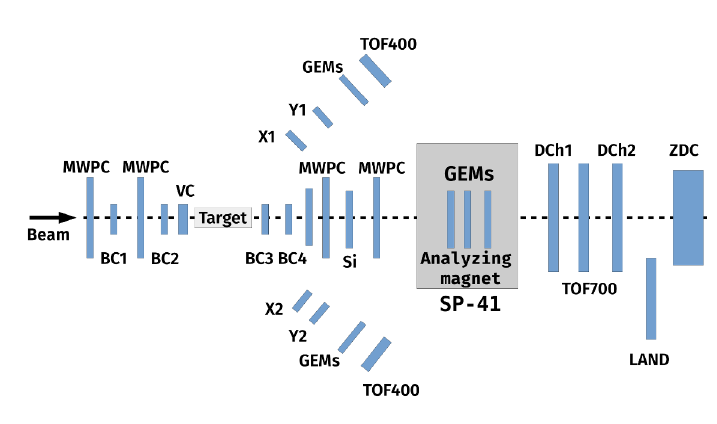
Figure 1. Schematic presentation of the experimental setup for SRC at BM@N experiment (not to scale). MWPC is multiwire proportional chamber; target is a 30 cm long vessel with liquid hydrogen; BC1, BC2, veto counter (VC), BC3, BC4 are scintillator-based beam counters; X1, X2, Y1, Y2 are scintillator trigger detectors of proton-proton arms; GEM is a gas electron multiplier station; TOF is a time-of-light detector; DCh is a drift chamber station; LAND is a large area neutron detector; ZDC is a hadron zero degree calorimeter